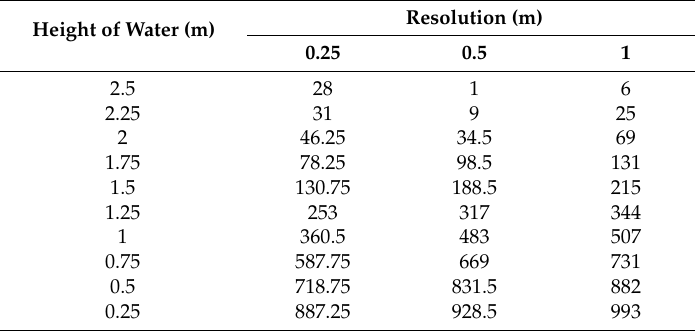
Table A5. Creek B Surface Area (m 2 ) from Terrestrial